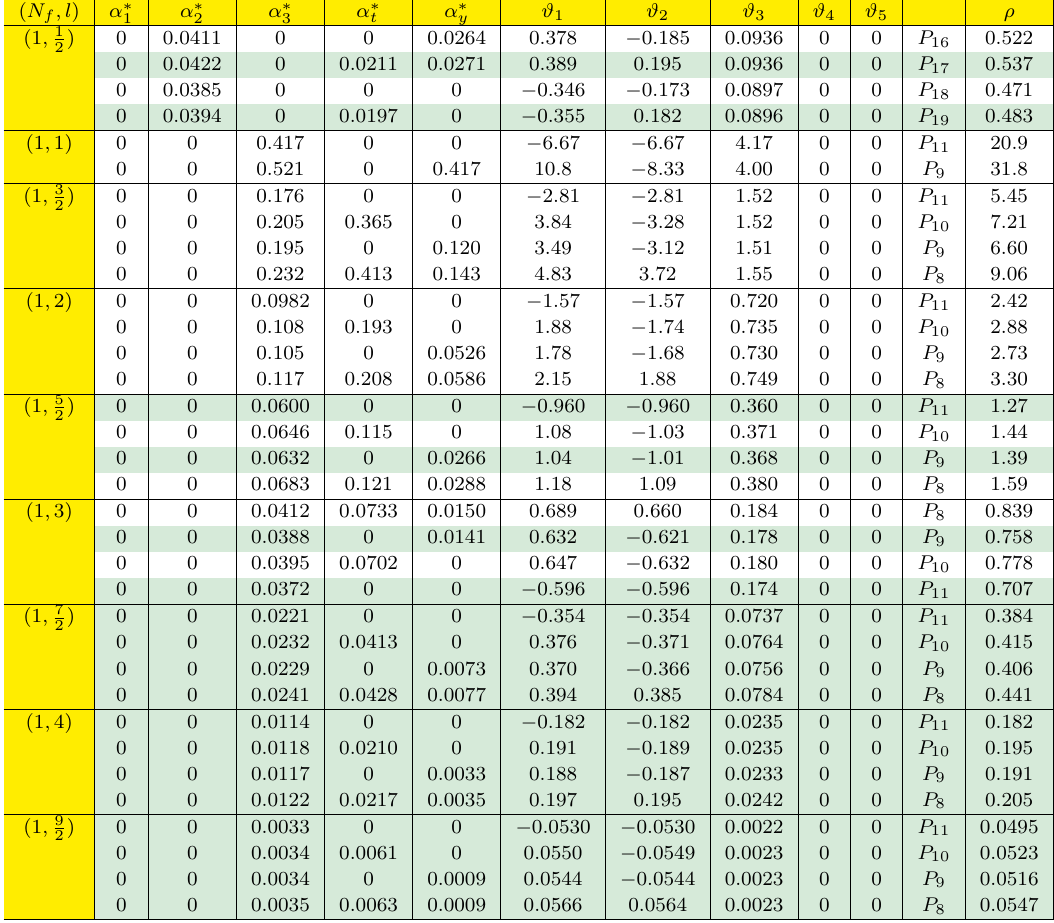
or (cid:11) depending 2 3